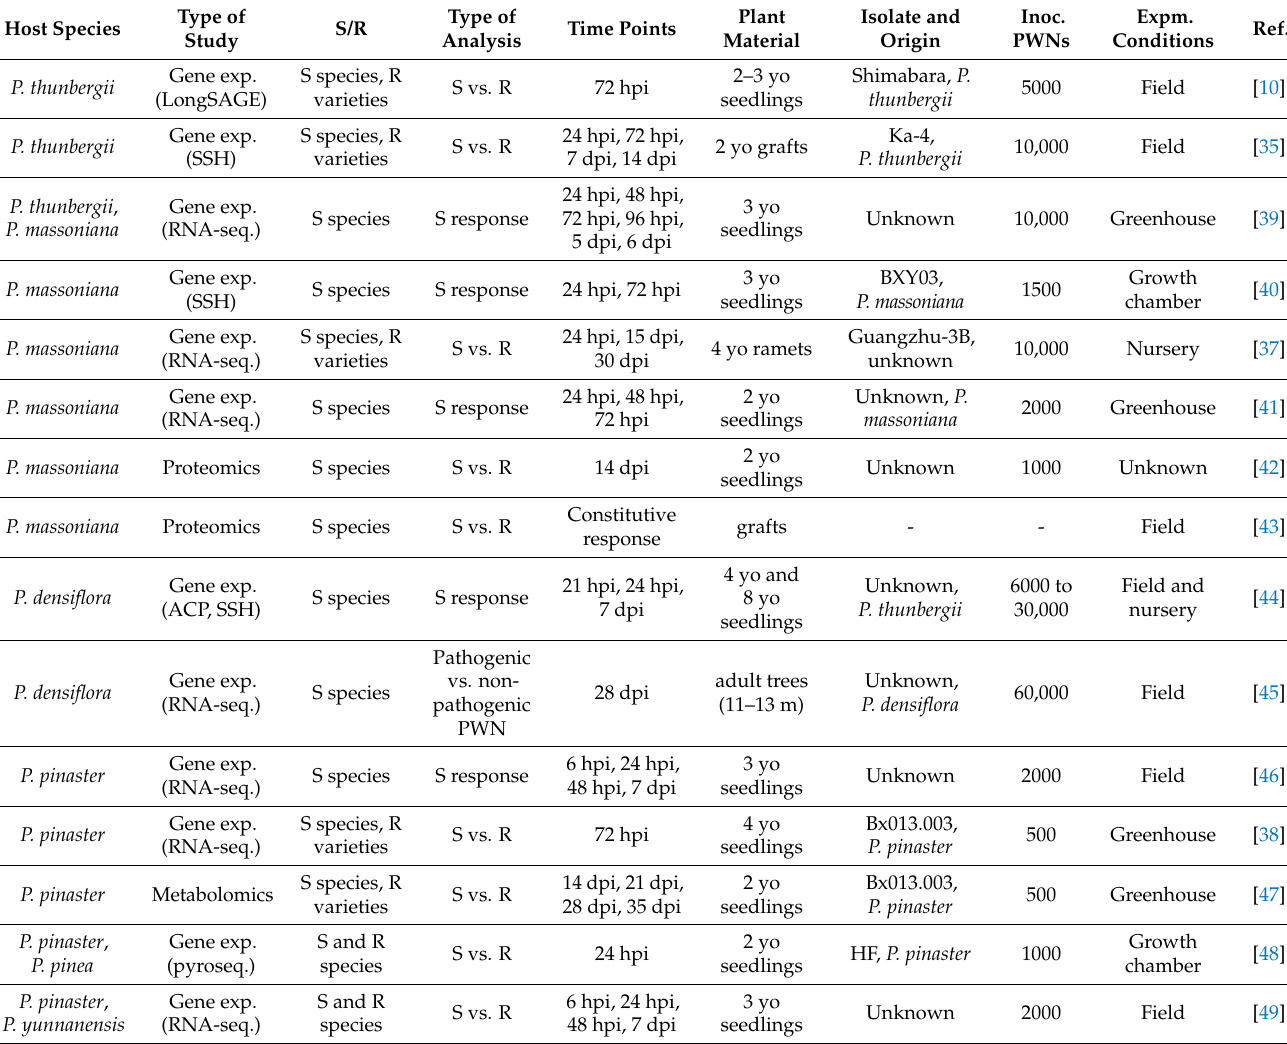
mechanisms involved both in the susceptible and resistant responses. Table 1. Details of the molecular response studies on pine trees infected with pinewood nematode